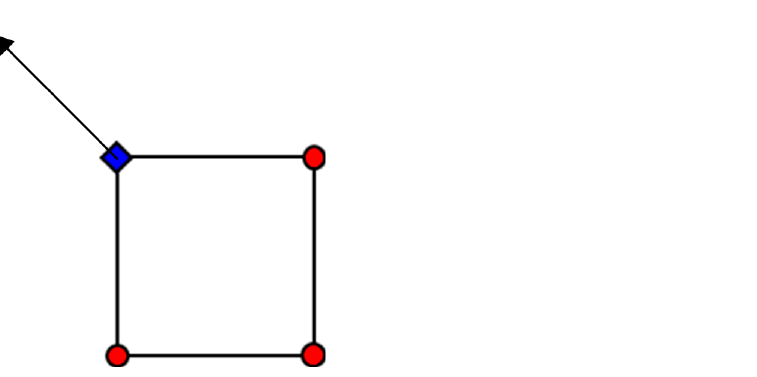
Figure 2. The proposed method of exciting the considered system to vibrations.